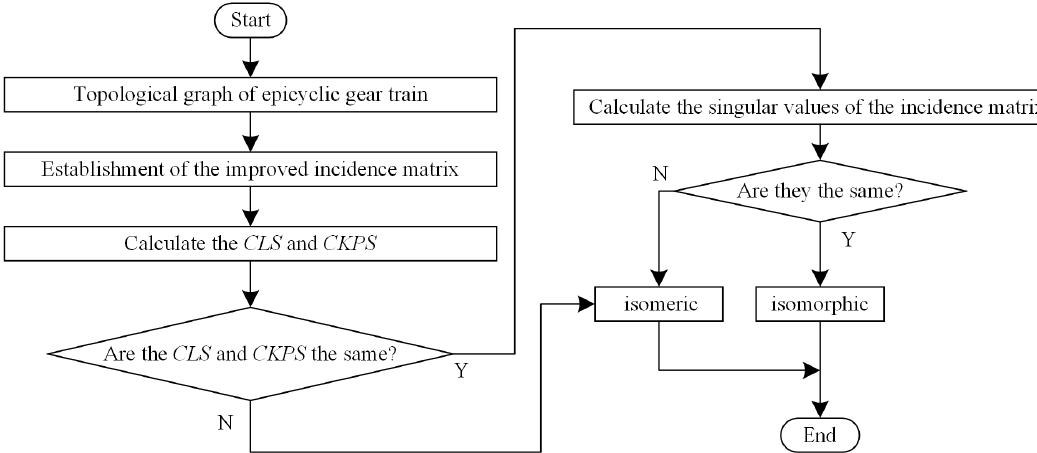
Figure 2. The flowchart of isomorphism identification.